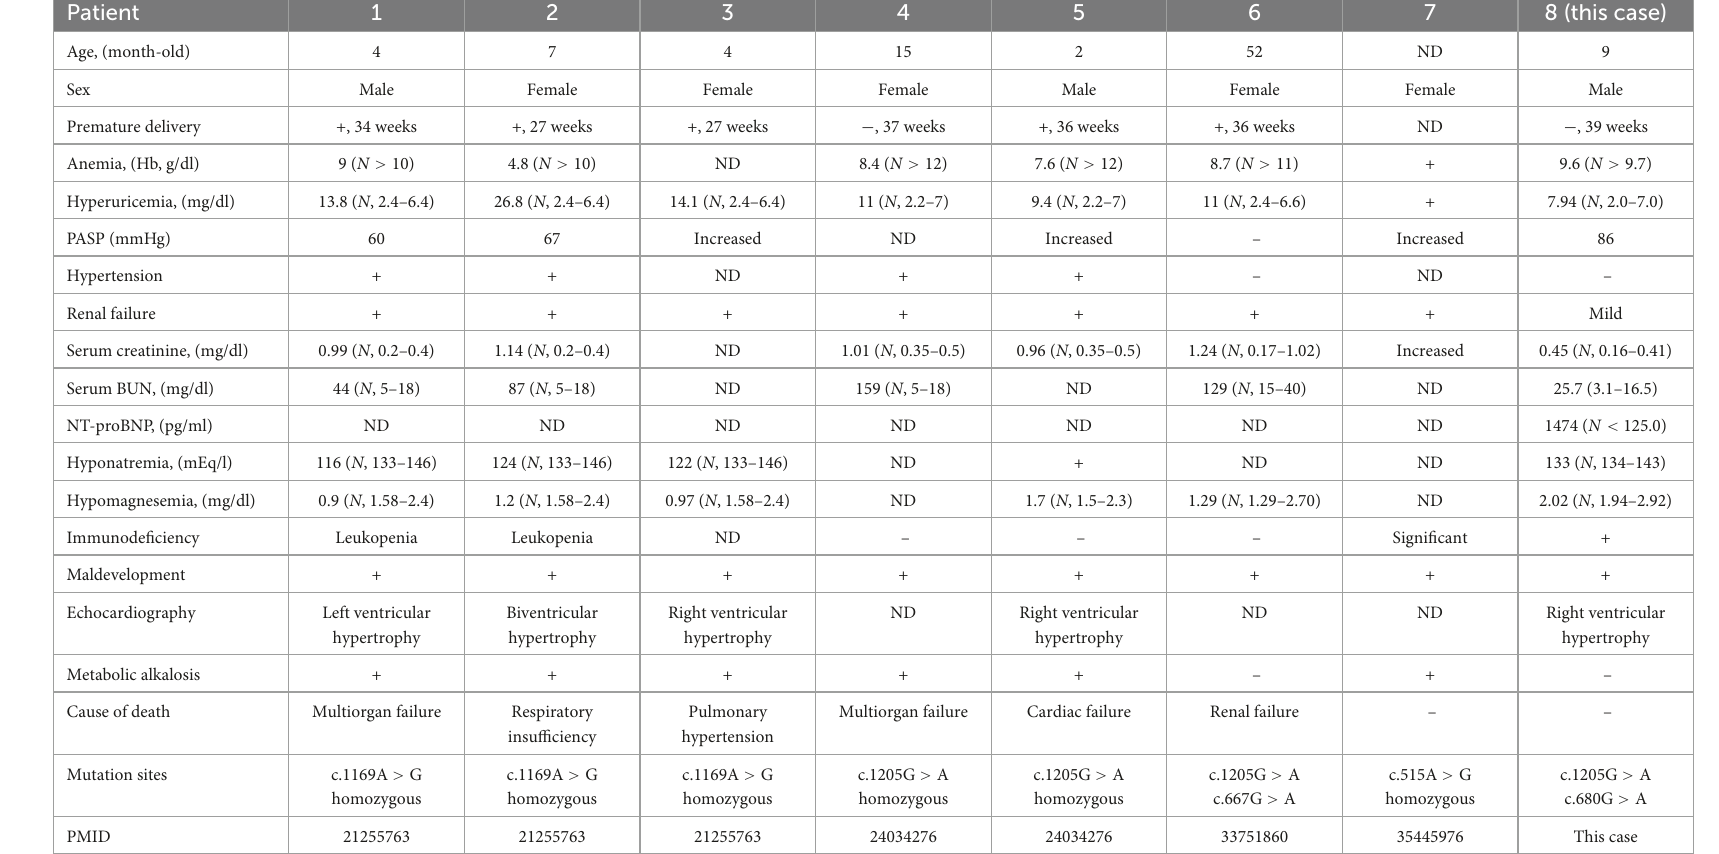
TABLE 3 Comparison of clinical manifestation of HUPRA